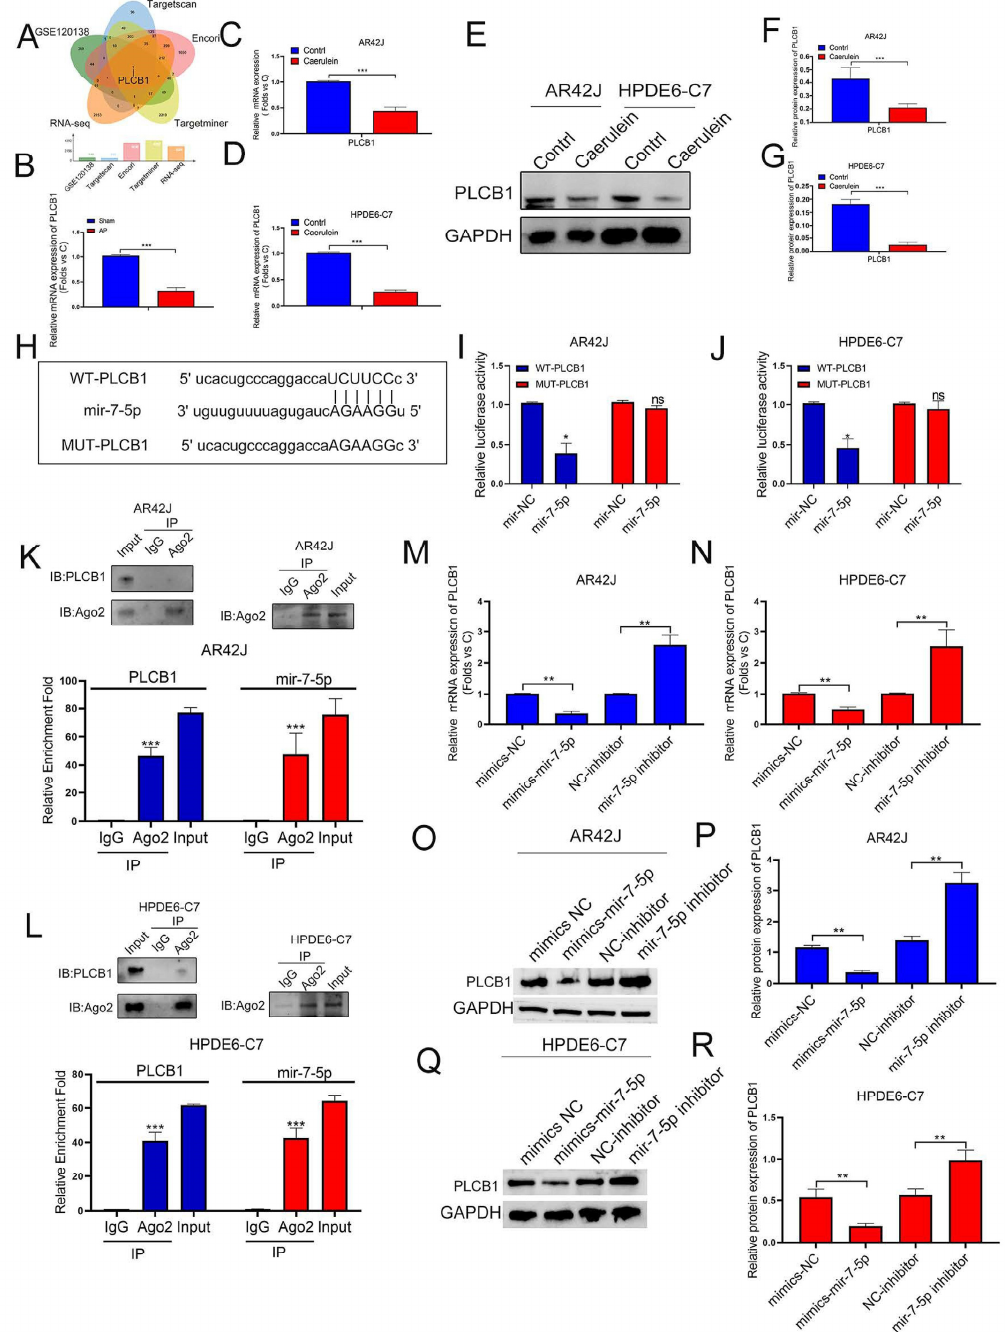
Figure 5. MiR-7-5p binds to PLCB-1 and regulates its expression in pancreatitis. ( A ) The potential target mRNAs of miR-7-5p were predicted in a public database and intersected with RNA-seq data to find AP-related genes. ( B – G ) The expression of PLCB1 was explored in rat tissues, AR42J, and HPDE6-C7 cells by Q-PCR assay and WB assay. ( H ) Schematic diagram of the PLCB1-WT and PLCB1-Mut luciferase vectors. ( I , J ) Relative luciferase activities in AR42J and HPDE6-C7 cells co- transfected with PLCB1-WT or PLCB1-Mut and the miR-7-5p mimic, inhibitor, or corresponding negative control. ( K , L ) The interaction between miR-7-5p and PLCB1 was confirmed by RIP assay in AR42J and HPDE6-C7 cells. ( M – R ) The regulation effect of MiR-7-5p expression on PLCB1 was observed by qPCR assay and WB assay in AR42J and HPDE6-C7 cells. The data are presented as means ± SDs, n = 3 for each group, * p < 0.05; ** p < 0.01; *** p < 0.001, ns = no significance between the indicated